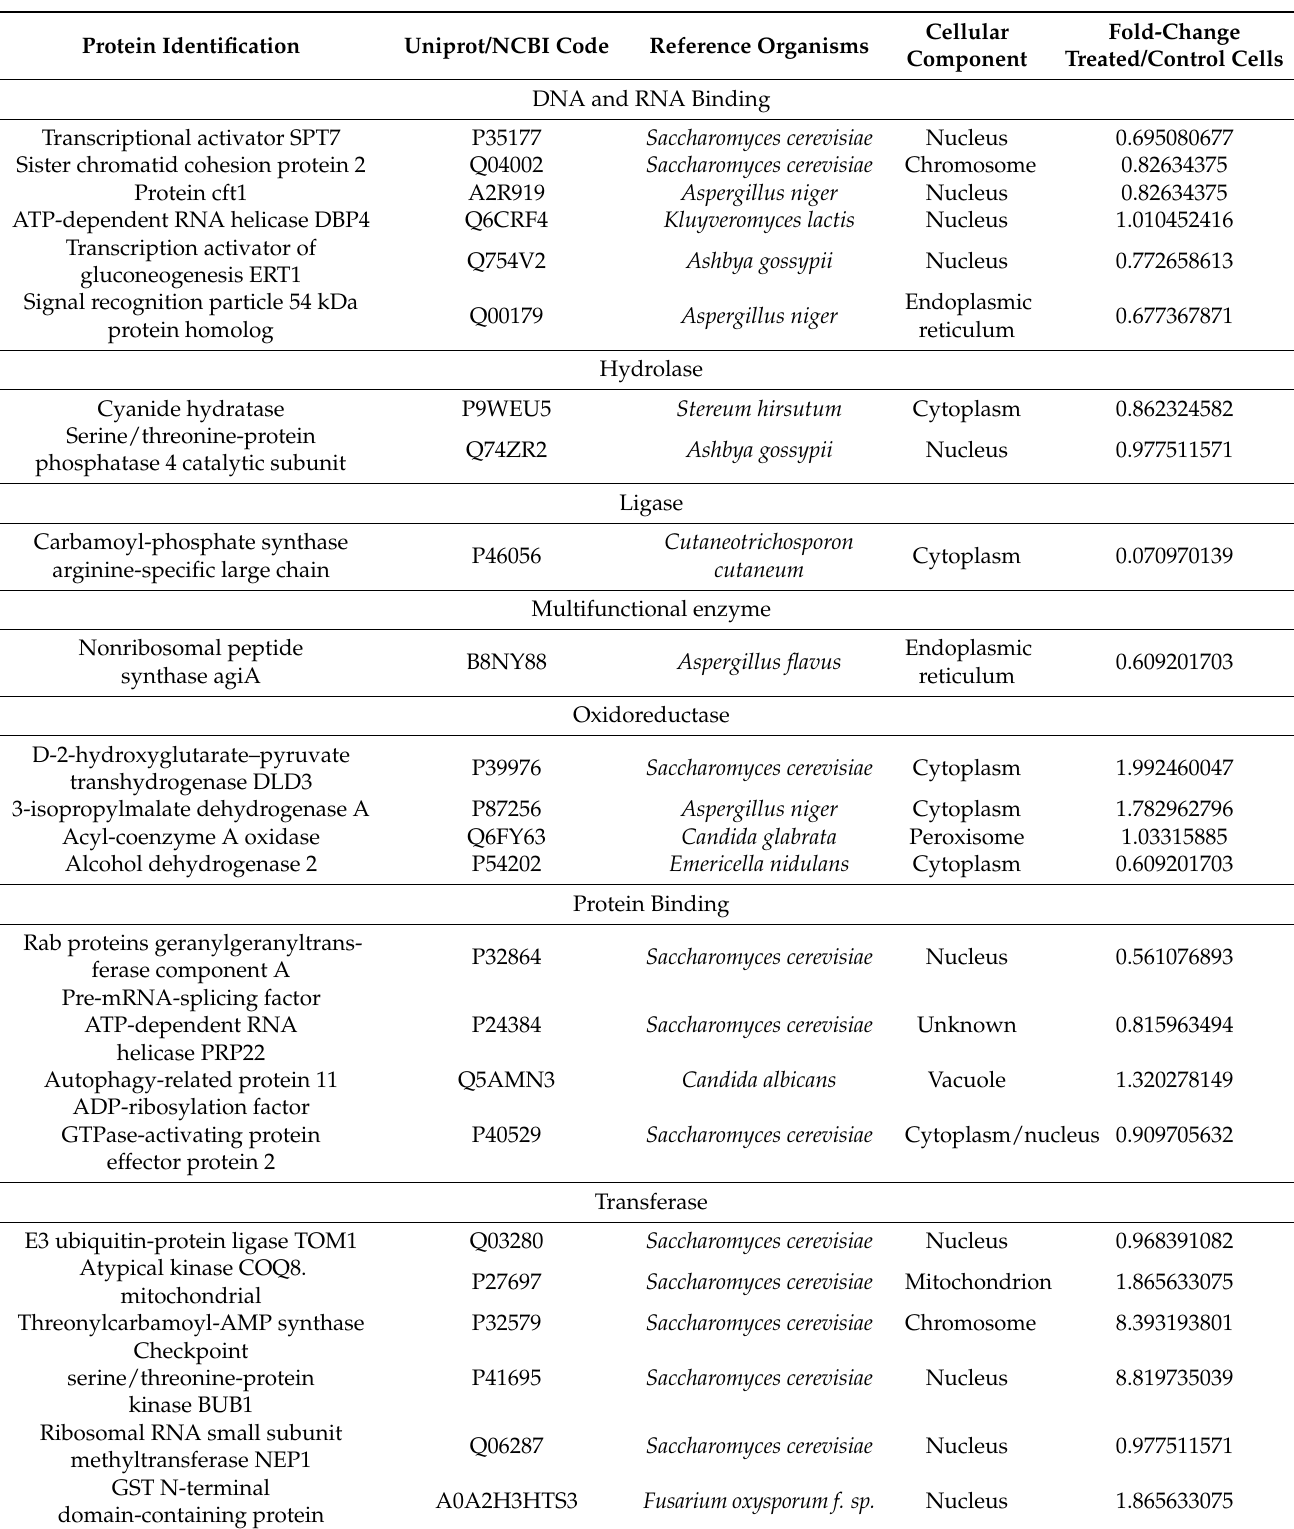
Table 1. Overlapping proteins identified in control and treated cells of C. neoformans by LC-ESI- MS/MS